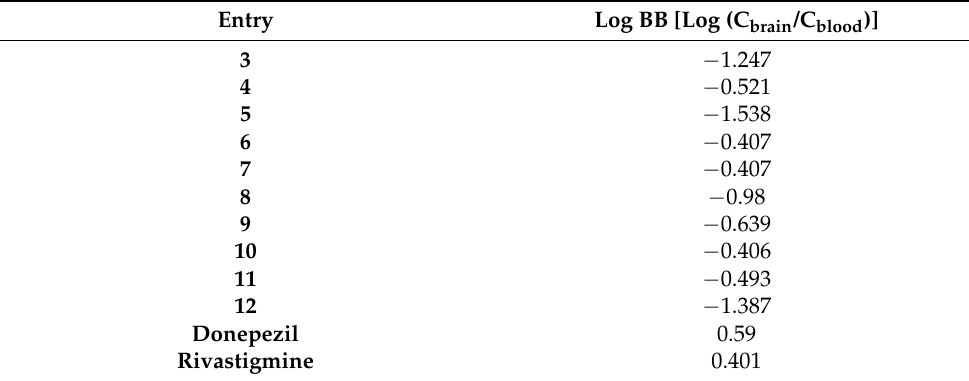
Table 8. Log BB value of phenoxyindole